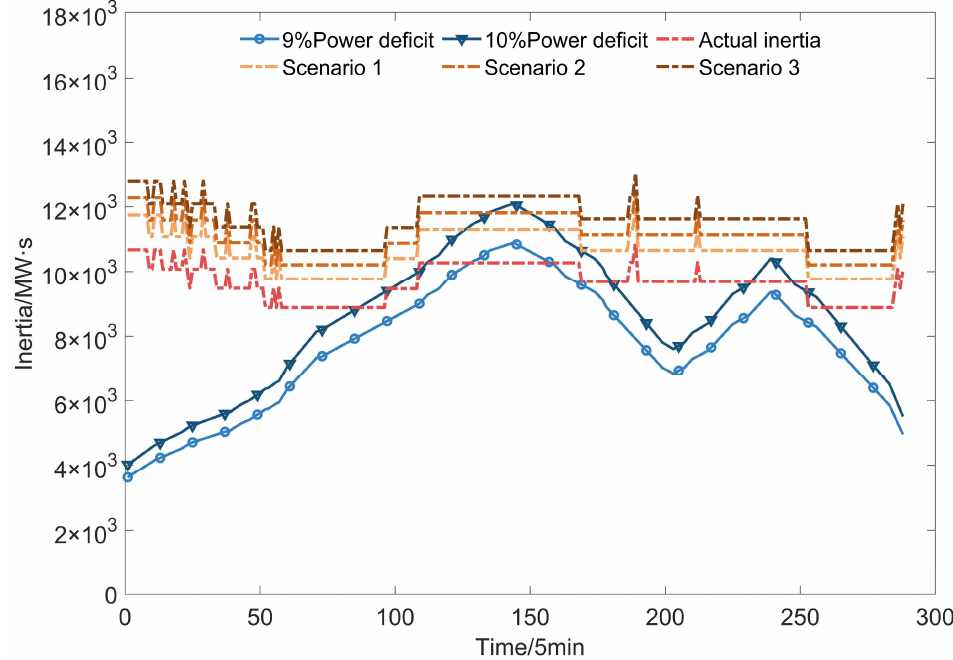
Figure 8. Results with different inertia margin coefficients for real-time scheduling.